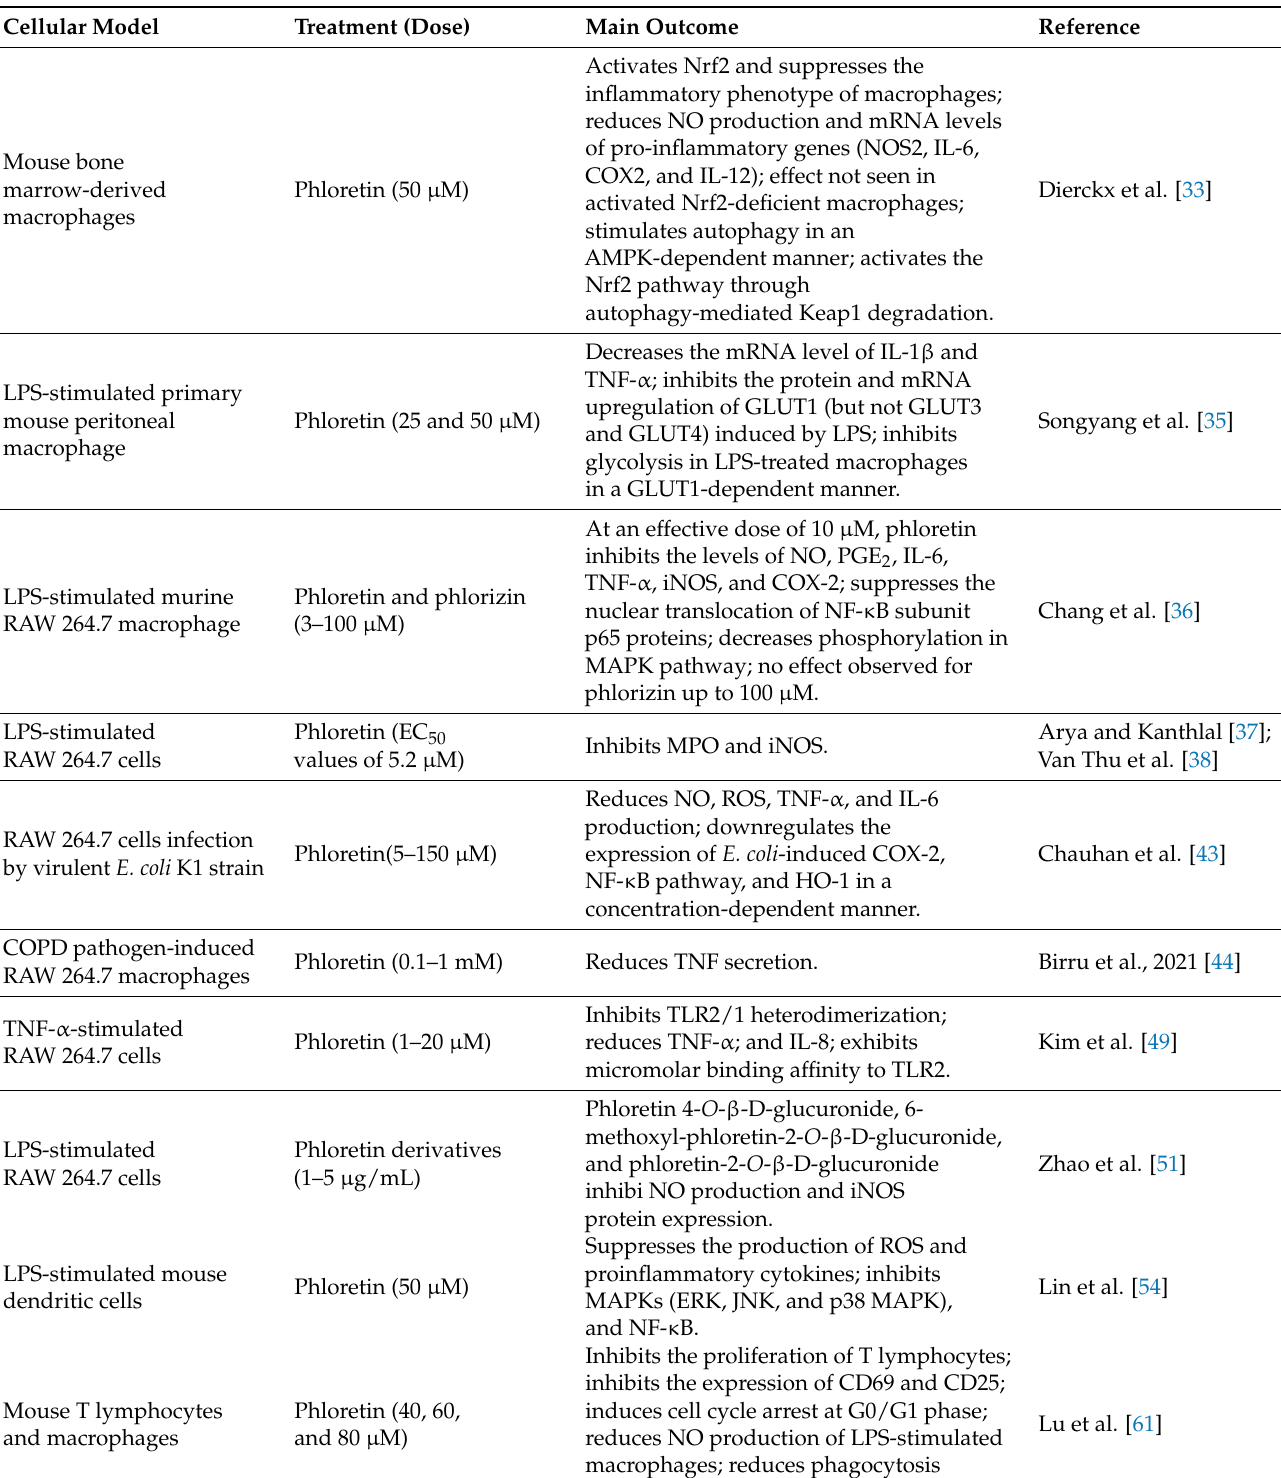
Table 1. Summary of the effects of phloretin and related compounds on macrophages and other immune cells